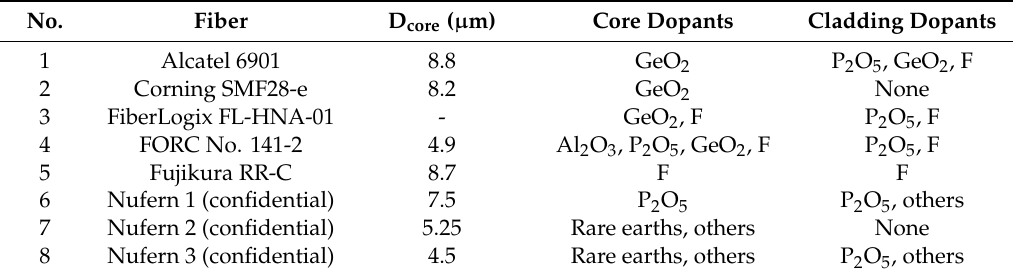
Table 1. Optical fibers for the fabrication of chiral LPGs (CLPGs). Data by manufacturers and authors of [65].